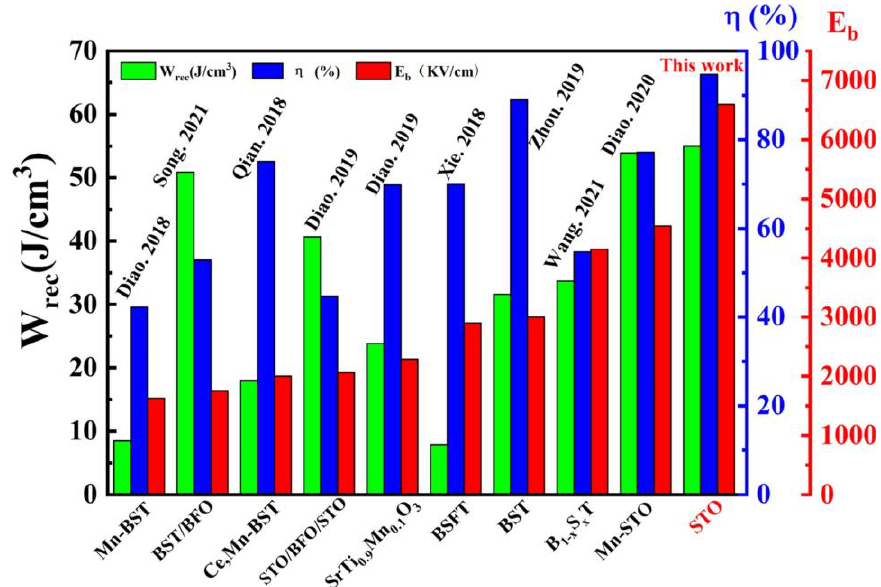
Figure 7. Comparison of energy storage performances between the STO film annealed at 650 °C